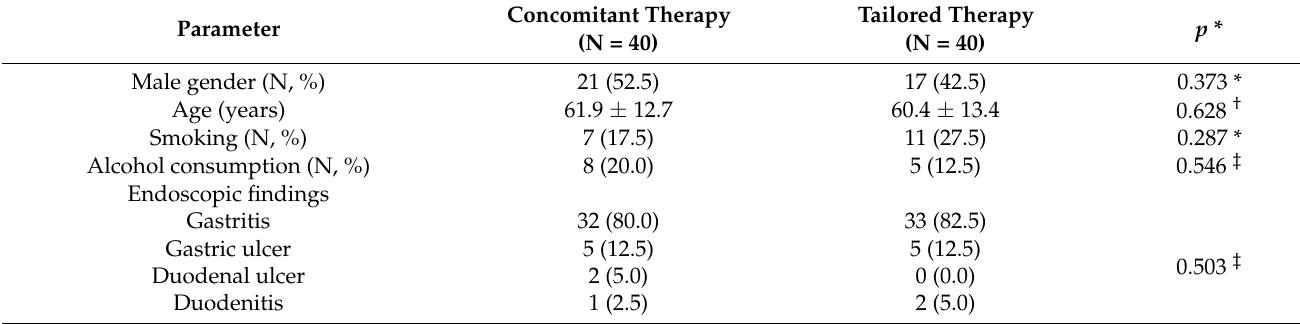
Table 1. The baseline characteristics of the study